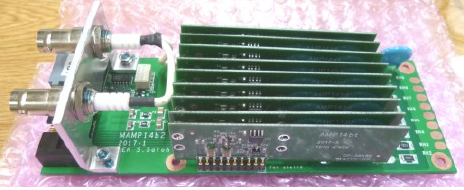
Fig. 2. PSD amplifier board .